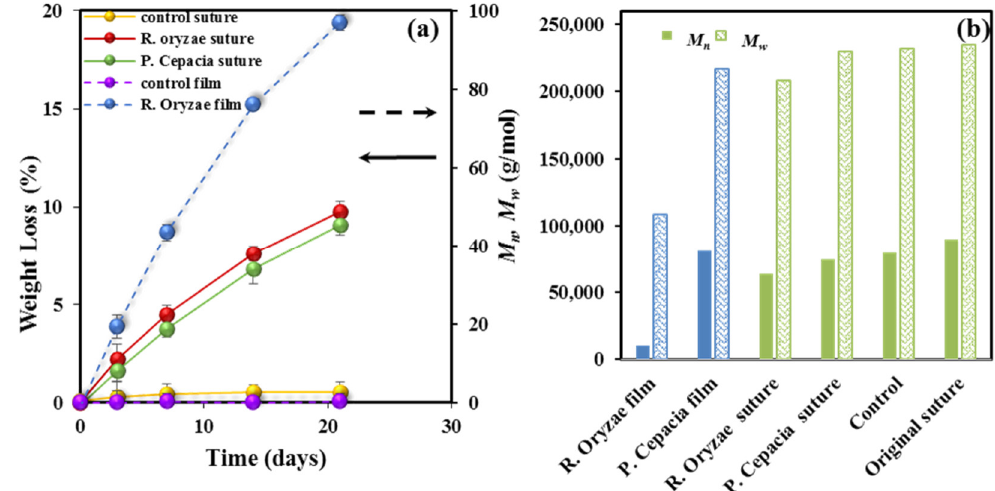
Figure 2. ( a ) Weight loss versus exposure time for P4HB sutures exposed to the indicated enzymatic media. Results are also plotted for the control and a melt pressed film (right vertical axis, dashed arrow) exposed to the Rhizopus oryzae medium for 21 days. ( b ) M n (full bars) and M w (weave bars) molecular weights of the initial suture, the control and sutures after exposure for 21 days to the indicated enzymatic media. For the sake of completeness, the results obtained from a melt pressed film are also depicted (blue bars).